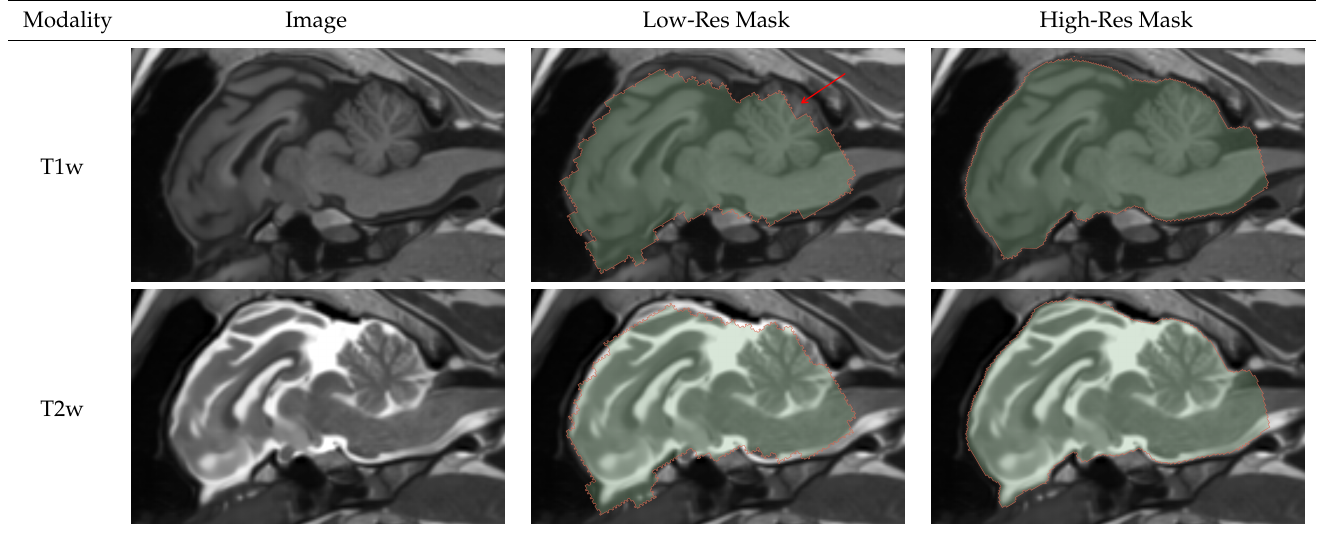
Figure 2. Result visualization for low and high-resolution brainmask models on T1 and T2 weighted images. The low-resolution model robustly detected the brain from a large volume, allowing for image cropping and generating an accurate high-resolution brainmask.